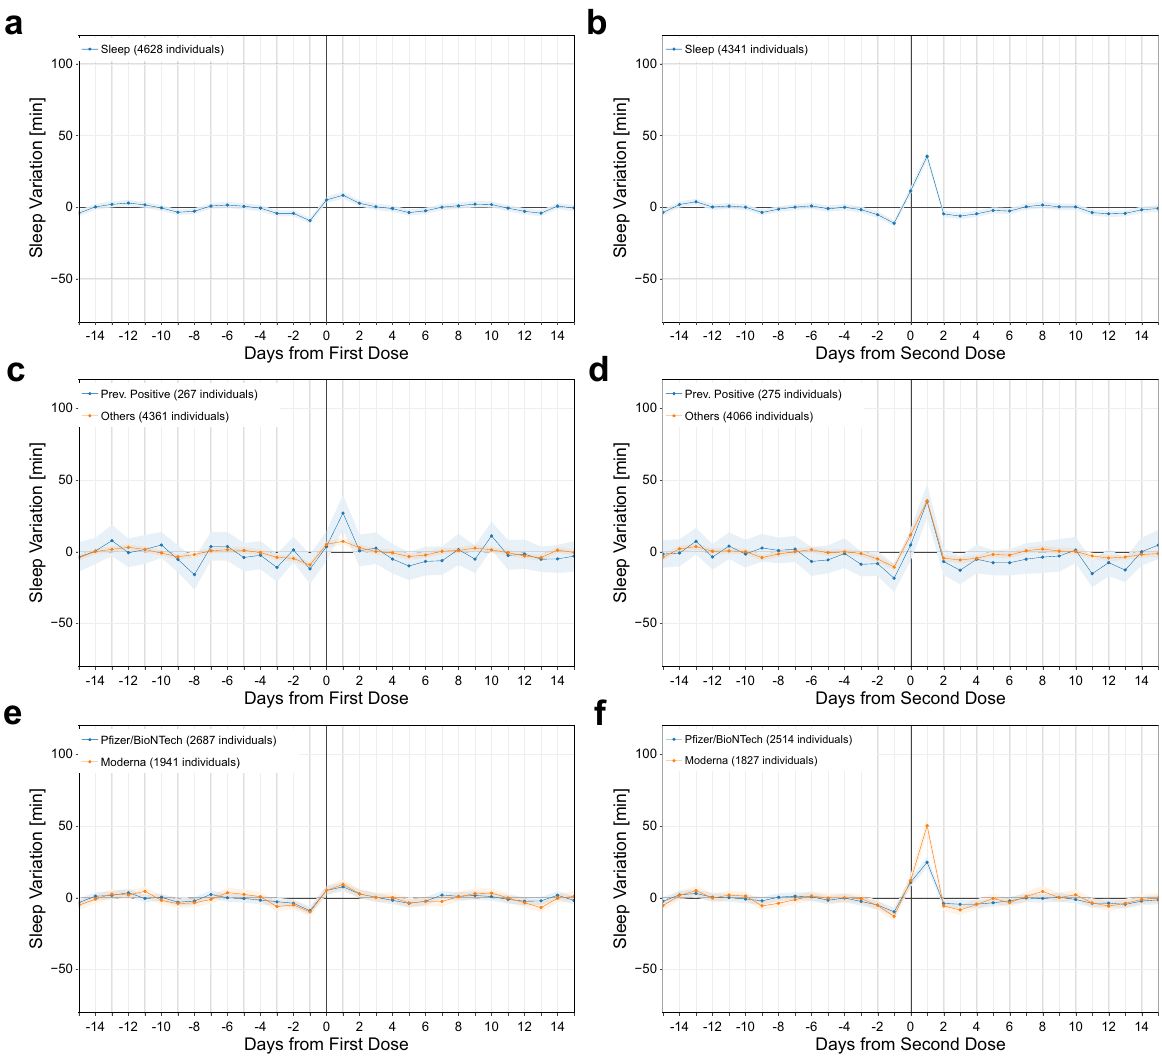
Fig. 4 Sleep metric changes post vaccination. Mean and 95% con fi dence interval of the absolute individual changes in sleep metric (in minutes) with respect to the individual baseline around the date of vaccination (day 0), for the fi rst dose of the vaccine ( a ), ( c ), ( e ), and for the second dose ( b ), ( d ), ( f ), for all individuals vaccinated ( a ), ( b ), for individuals previously tested positive to COVID-19 ( c ), ( d ), and for individuals vaccinated with the P fi zer-BioNTech or Moderna vaccines ( e ), ( f